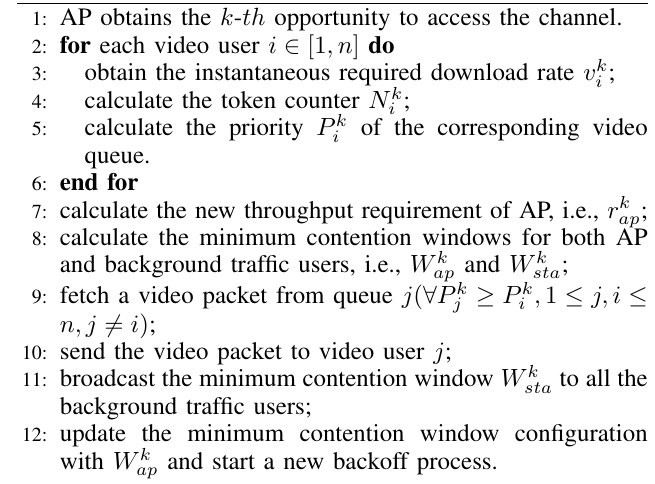
Algorithm 1 Bi-level resource allocation